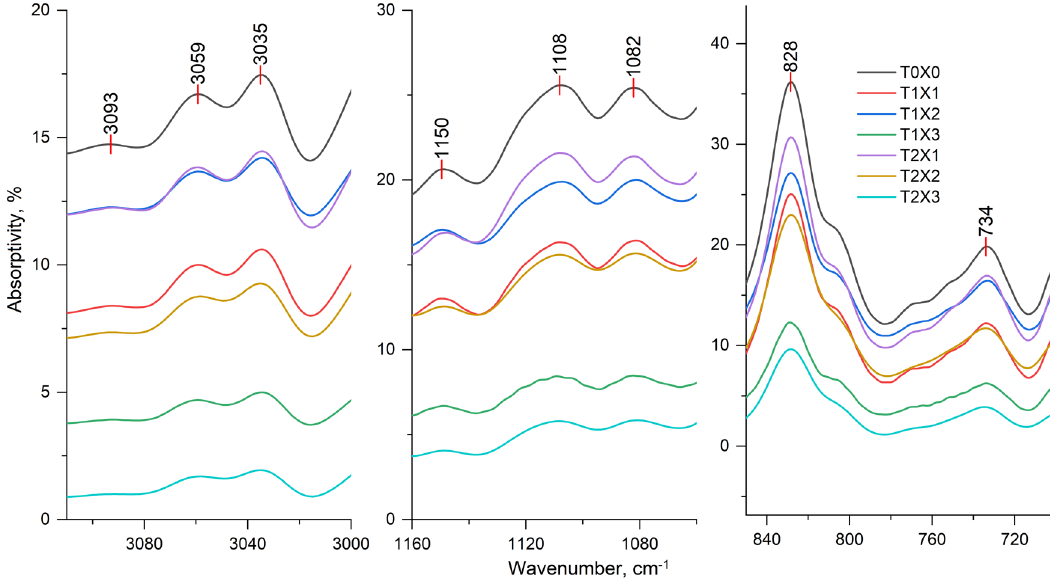
Figure 5: Infrared peaks area of specimen for crosslink conversion calculation.